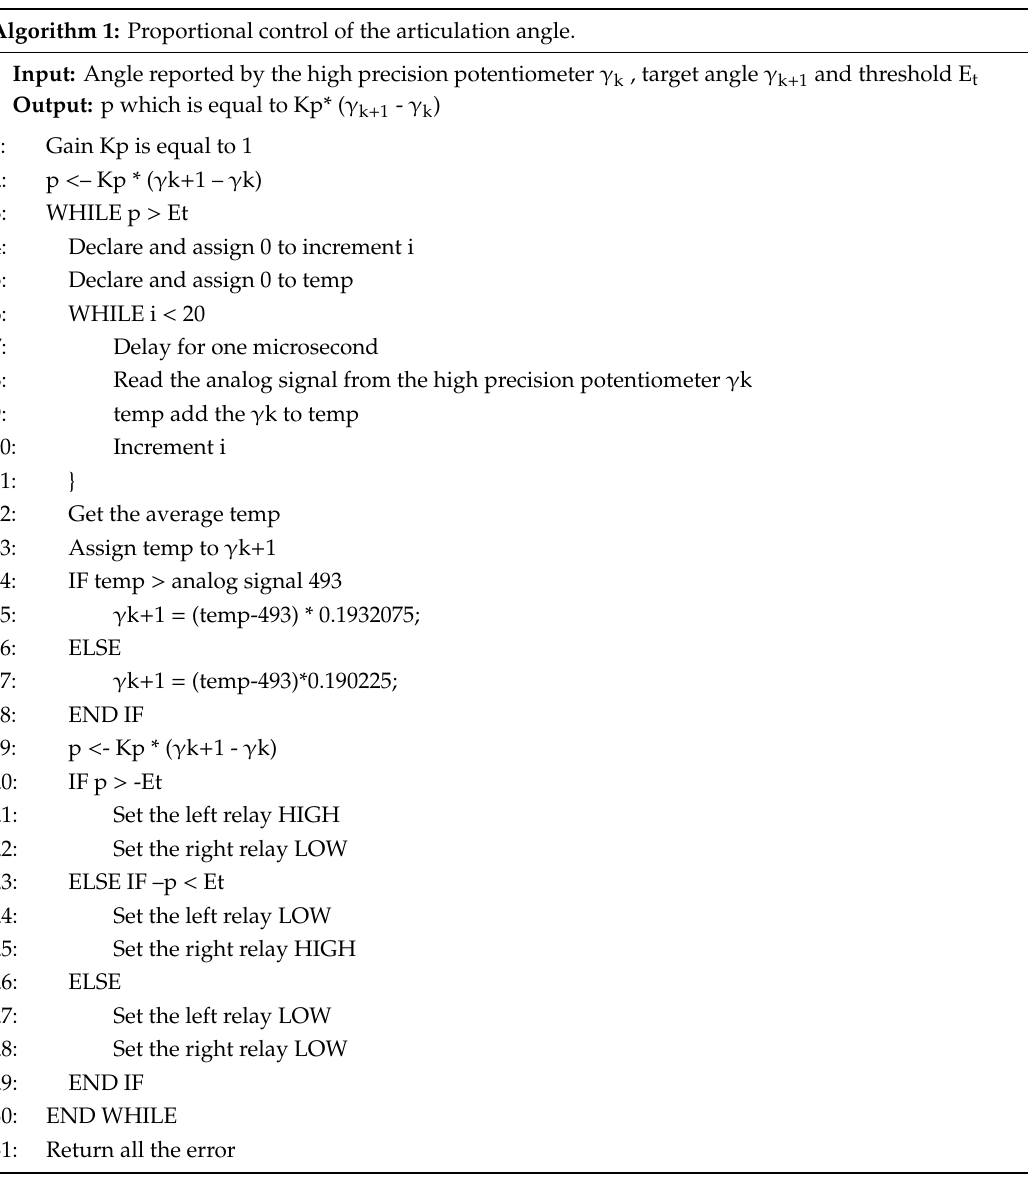
Algorithm 1: Proportional control of the articulation